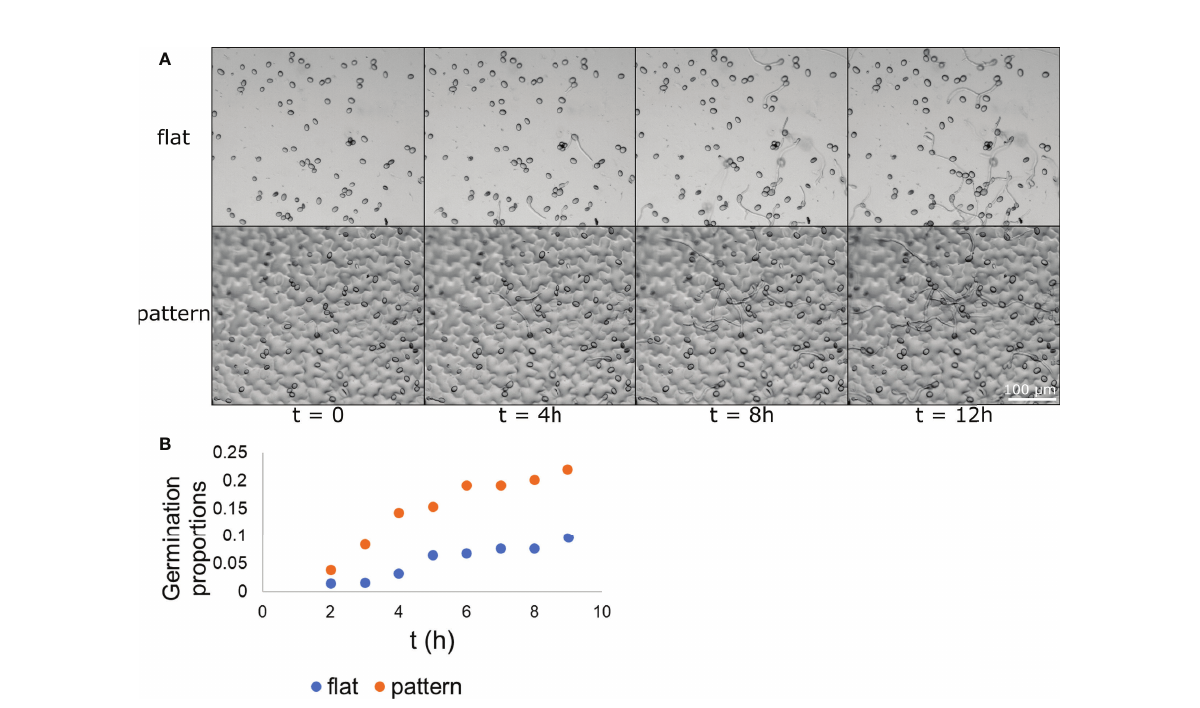
FIGURE 4 Conidia germination on fl at and patterned surfaces. B. cinerea conidia were applied to both a fl at (A – top) and a patterned (A-bottom) surface. The conidia germination process upon the surface was captured hourly and images from times 0, 4, 8, and 12 h are presented in (A) The conidia and their germ tube are clearly visible. The proportion of germinating conidia out of the entire spore population at different time points on each of the surface types was calculated and is presented in (B) The difference between the two populations is statistically signi fi cant starting from the 3 h time point with p <0.0025.